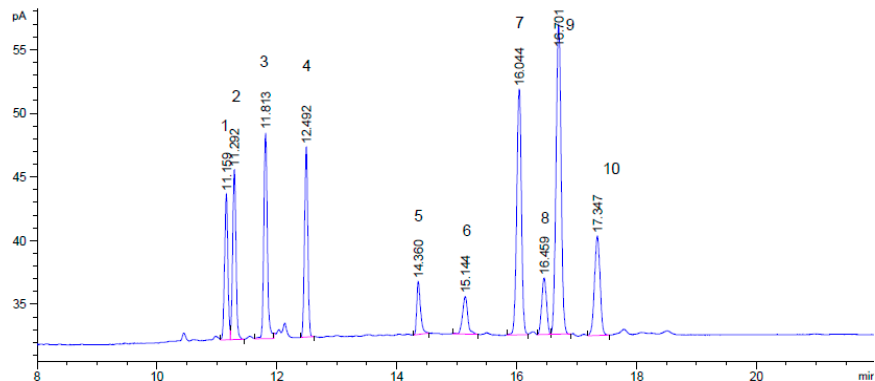
Figure 3. Gas chromatogram of standard monosaccharides. 1-Rhamnose; 2-Fucose; 3-Arabinose; 4-Xylose; 5 and 6-Fructose; 7-Mannose; 8-Galactose; 9-Glucose; and 10-Sorbose. Table 4. The monosaccharide profile, total sugar content, and M W of the samples.